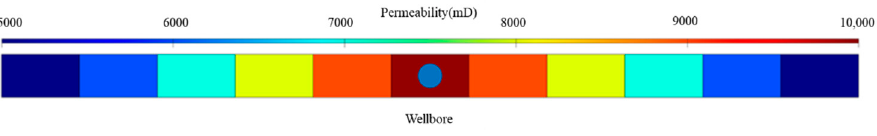
Figure 5. Numerical simulation process of embedded discrete fracture.